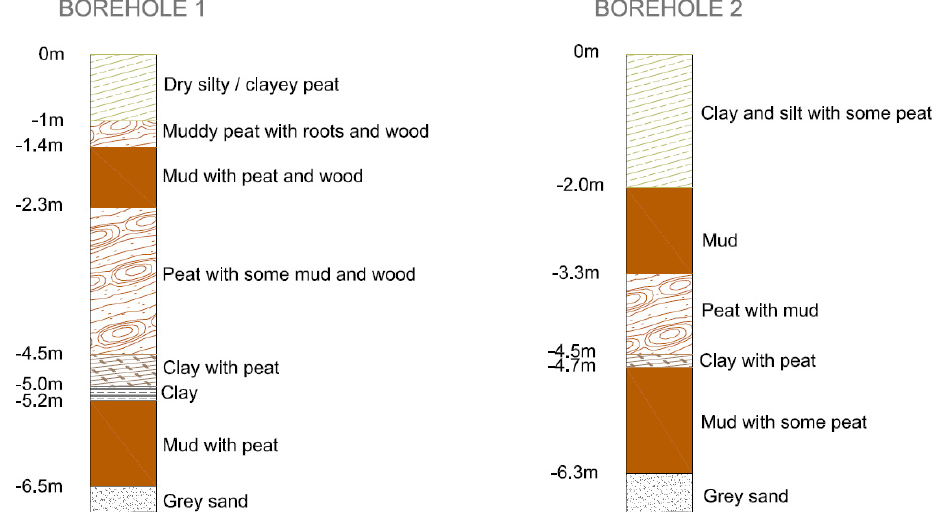
Fig. 4 Subsoil description of the deeper boreholes